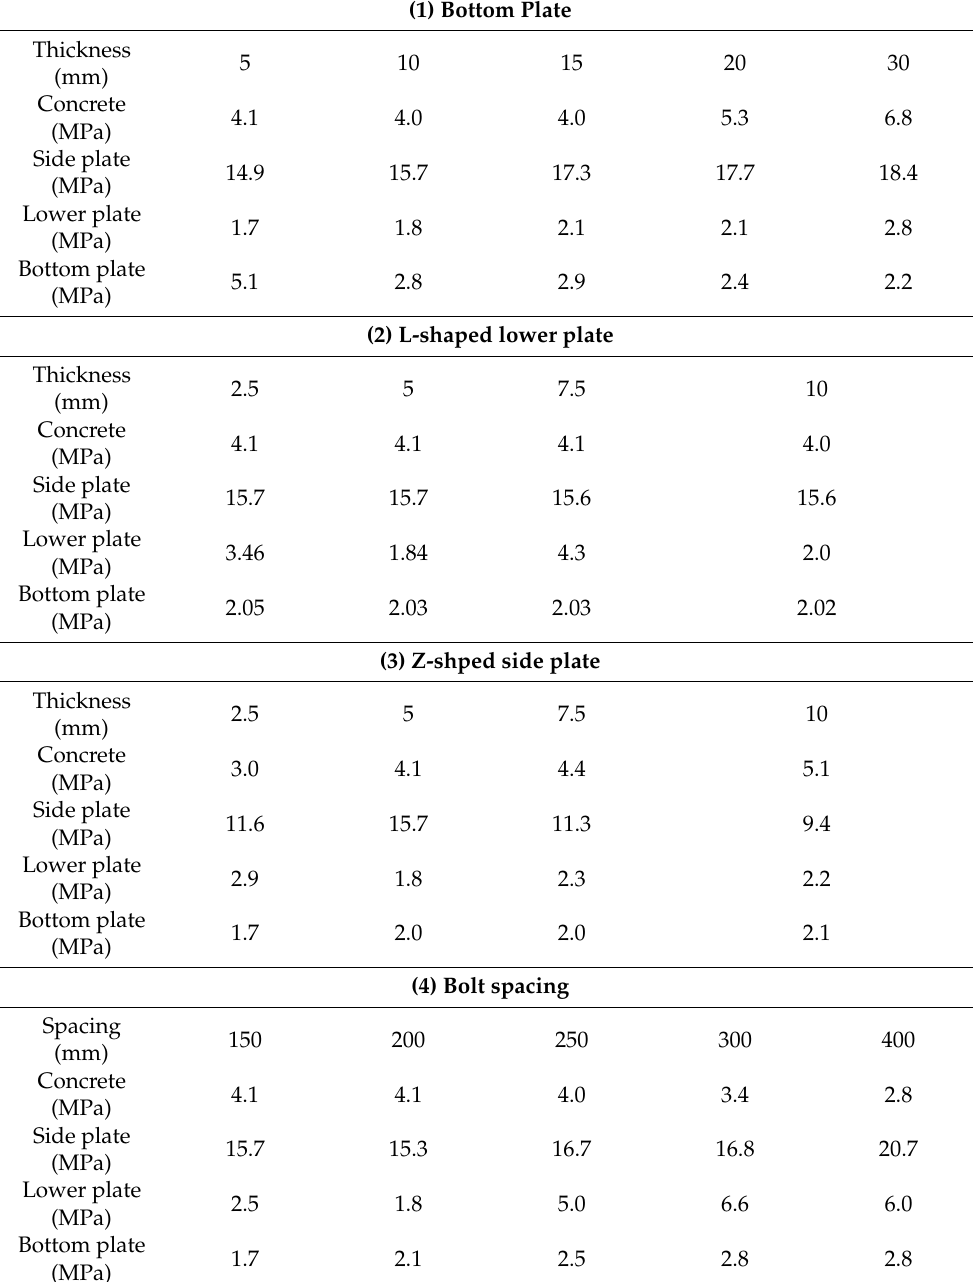
Table 2. The maximum stress of